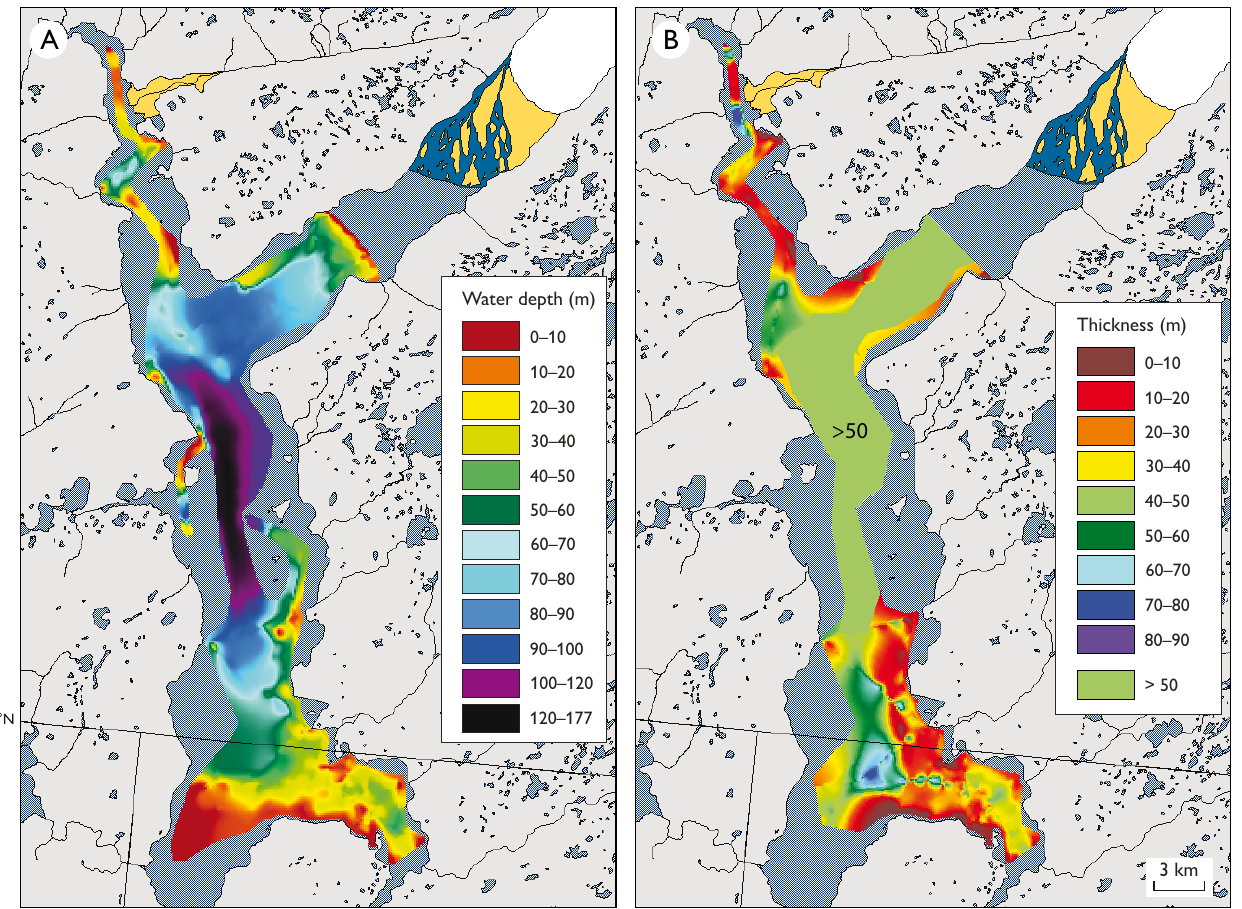
Fig. 3. A : Bathymetry of Lake Tasersuaq determined from echo sounder and C-boom seismic profiles. B : Sediment thickness. The area marked with ‘> 50’ indicates sediment thickness greater than 50 m. Here, the boomer signal could not penetrate the sediment succession any farther and so the exact thickness could not be